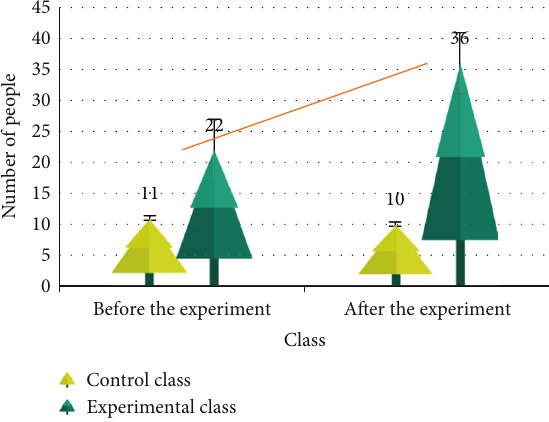
Figure 2: Comparison of the number of students with good technical standards in the two classes before and after the